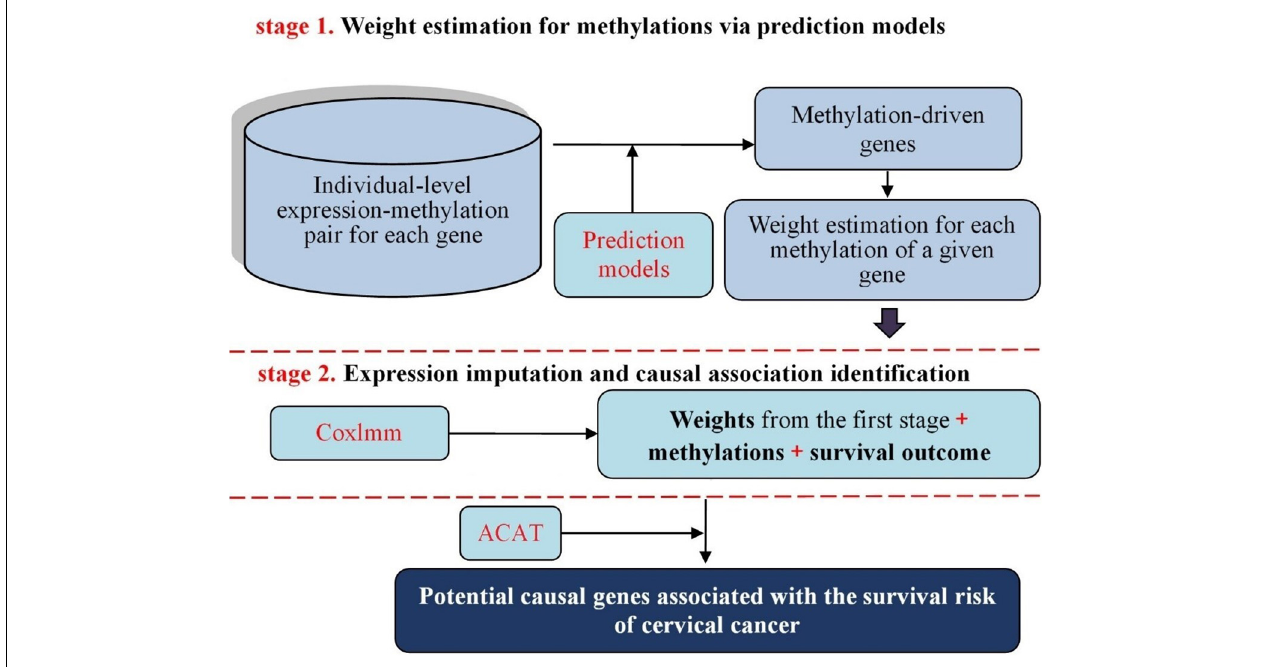
FIGURE 1 | Schematic framework of our proposed two-stage causal inference approach. Top: estimate the weight of each methylation site based on the methylation-expression pair of a given gene with various prediction models; Bottom: evaluate the association between methylation-regulated gene expression (MReX) and the survival of cervical cancer using the Cox linear mixed-effects model and then discover causal genes for cervical cancer in